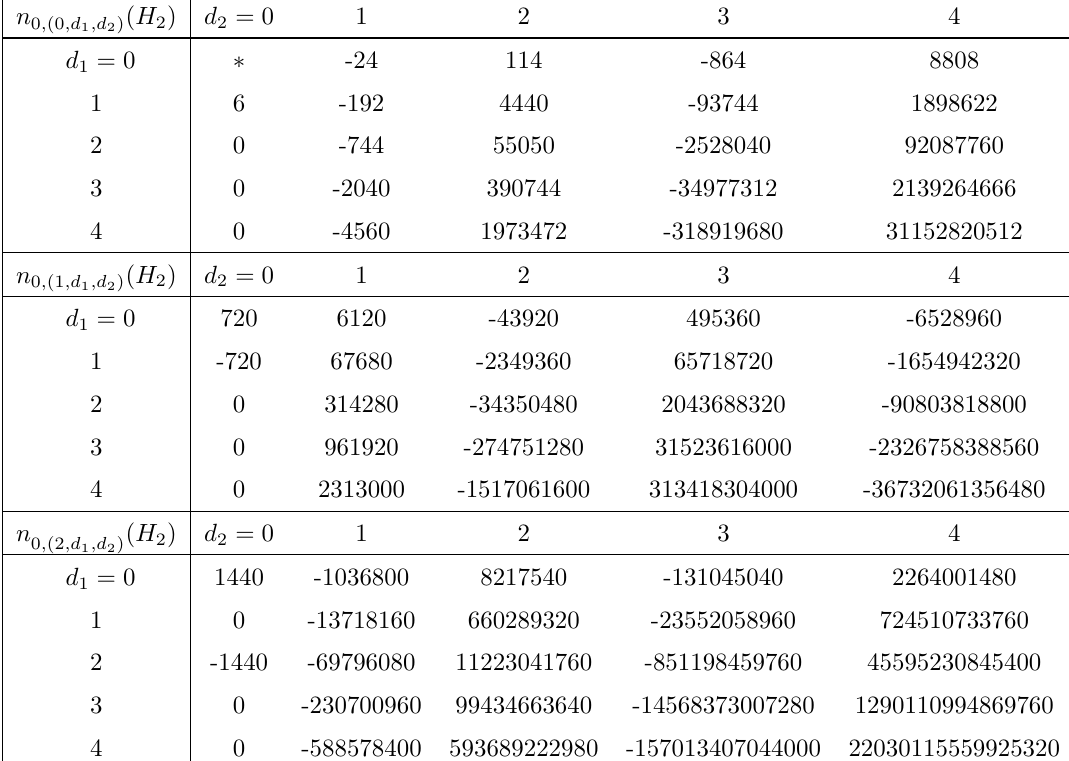
Table 4 . Genus 0 invariants associated to H 2 of M E 8 P 1 × P 2 for degree d e = 0 , 1 , 2 of the elliptic